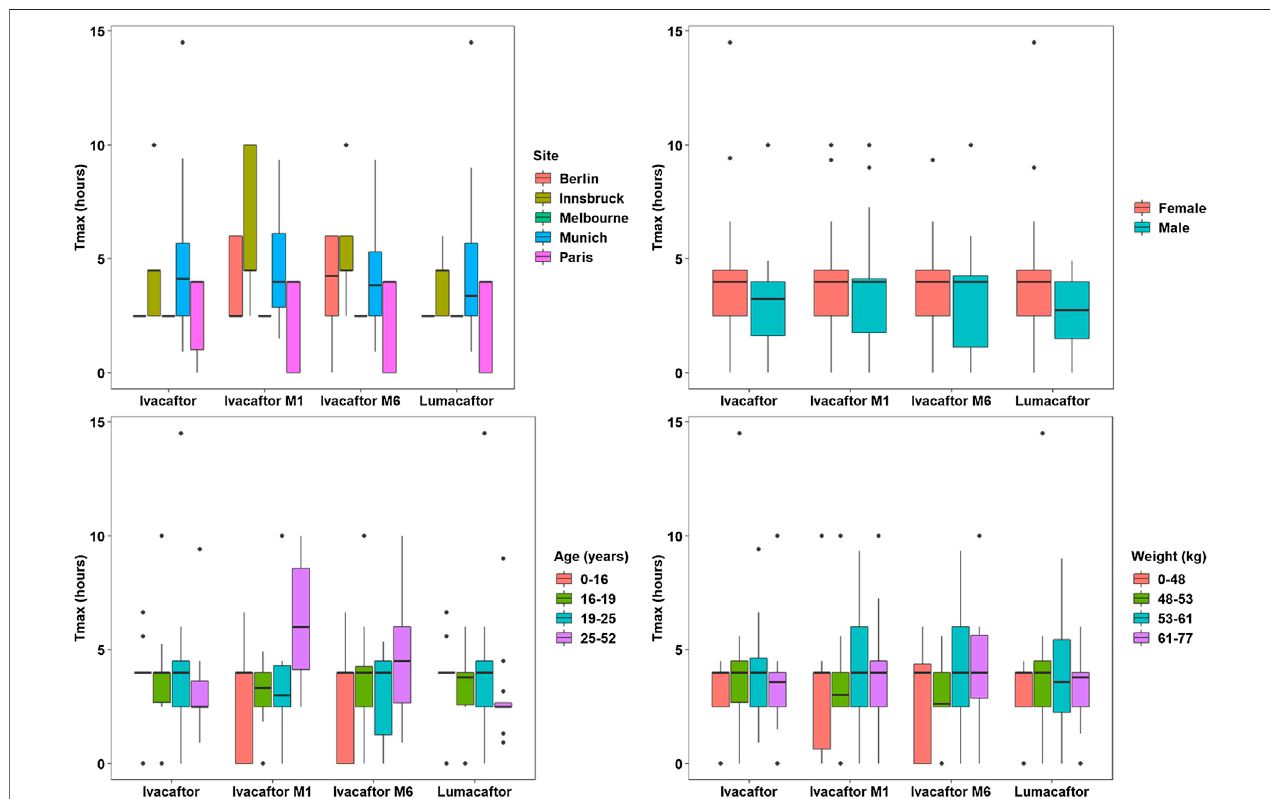
FIGURE 2 | Pharmacokinetic Analysis Plots - T max